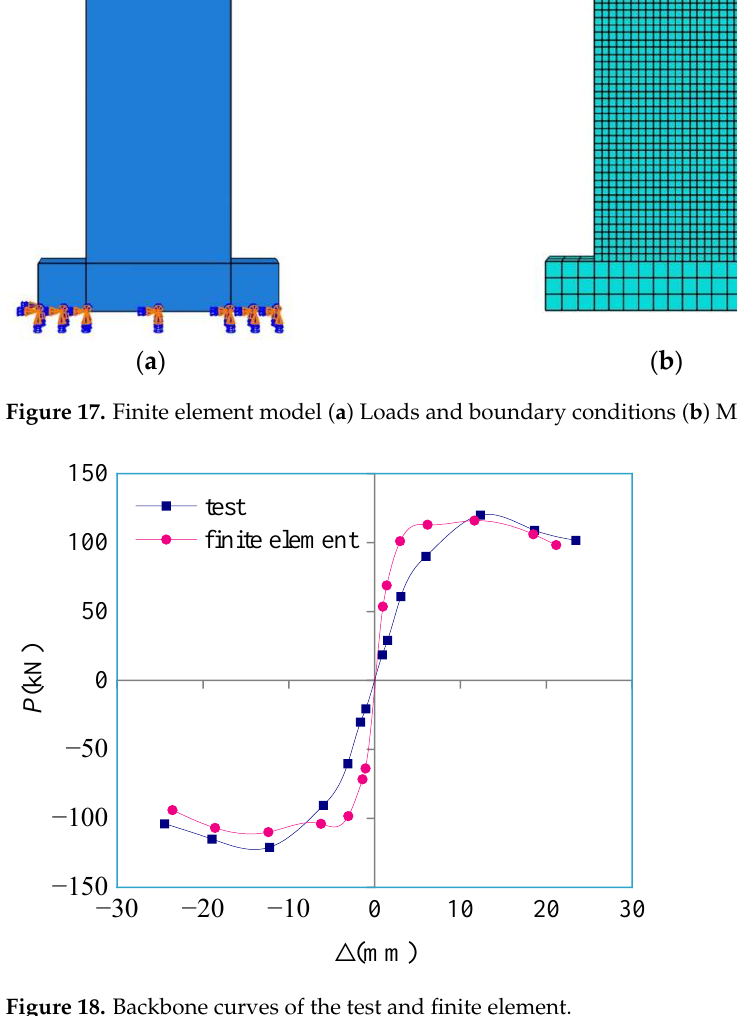
Figure 18. Backbone curves of the test and finite element. Table 10. Characteristic point bearing capacity and displacement of the test and finite element.